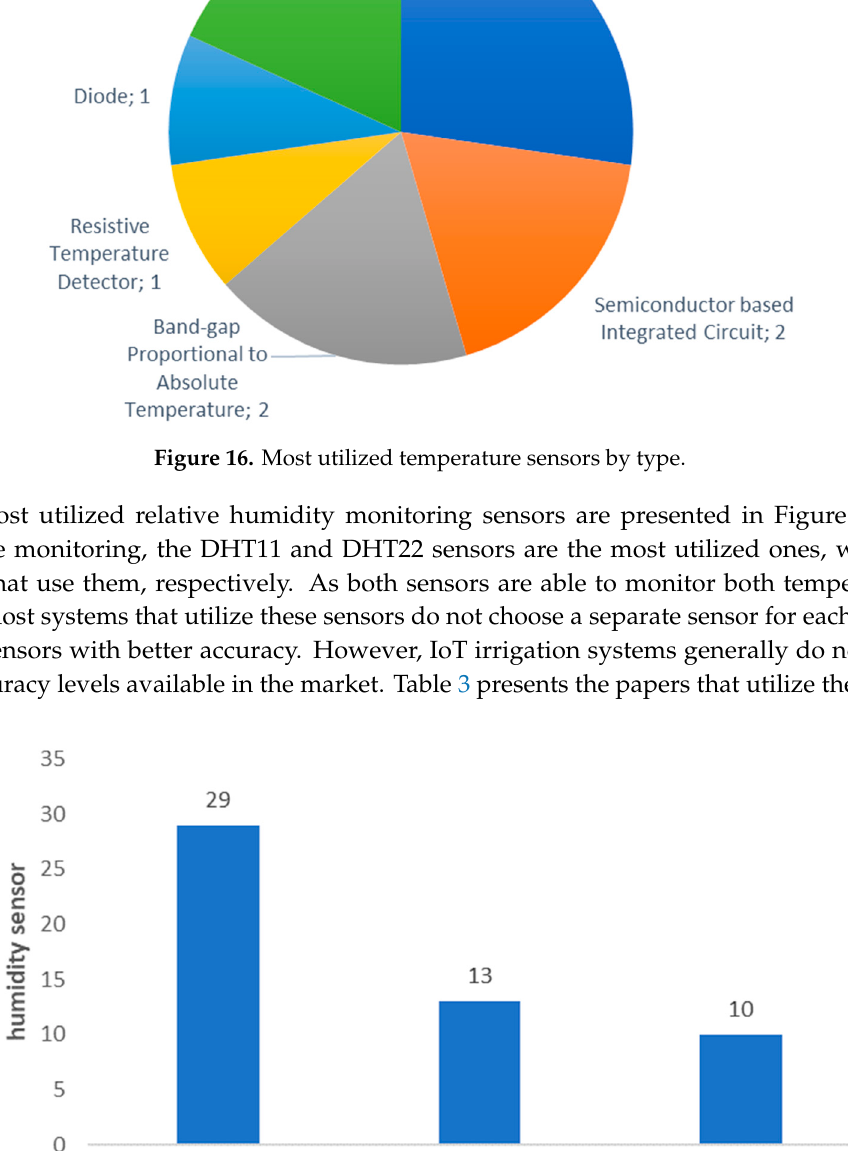
Figure 17. Most utilized humidity sensors. Table 3. Relative humidity monitoring sensors.